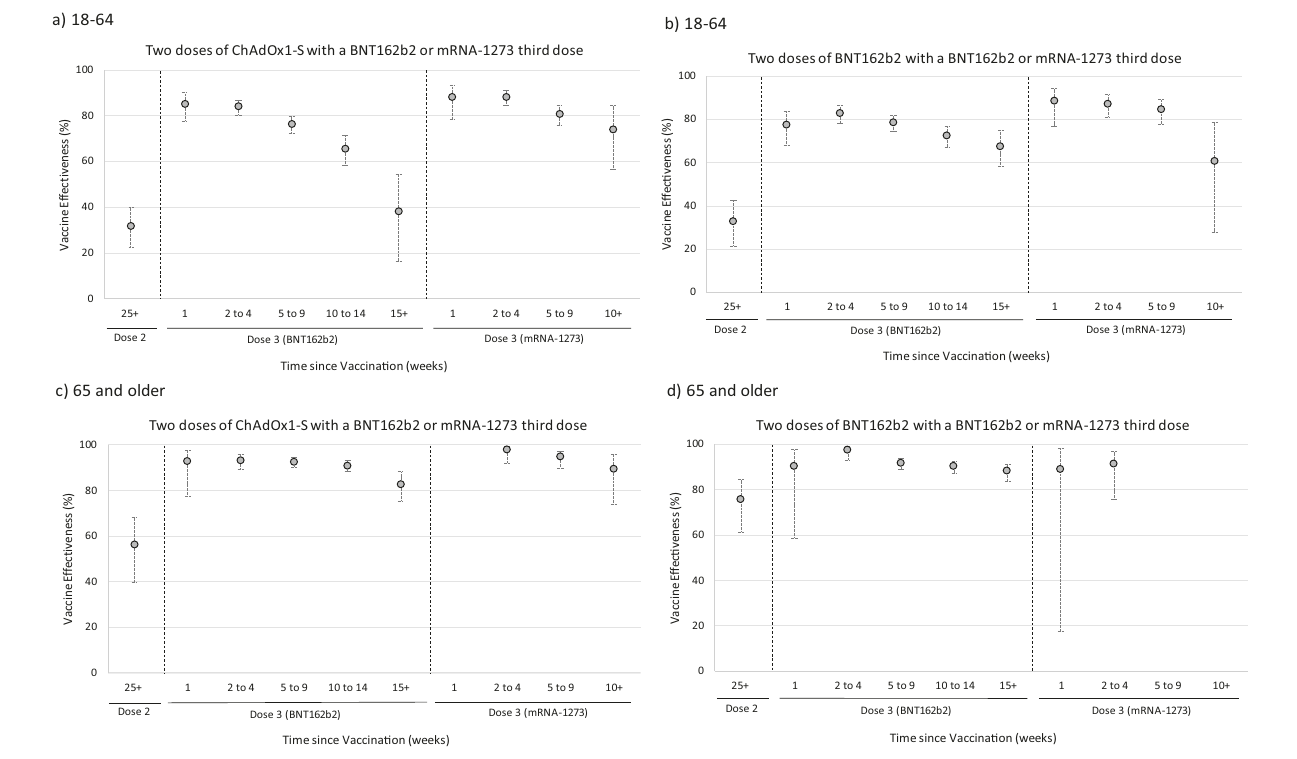
Fig. 2 | Vaccine effectiveness estimates with 95% con fi dence intervals against hospitalisations using ECDS by age group and manufacturer (all symptomatic controls, Omicron only). a 18 – 64: Two doses of ChAdOx1-S with a BNT162b2 or mRNA-1273 third dose, b 18 – 64: two doses of BNT162b2 with a BNT162b2 or mRNA-1273 third dose, c 65 and older: two doses of ChAdOx1-S with a BNT162b2 ormRNA-1273thirddose, d 65andolder:twodosesofBNT162b2withaBNT162b2